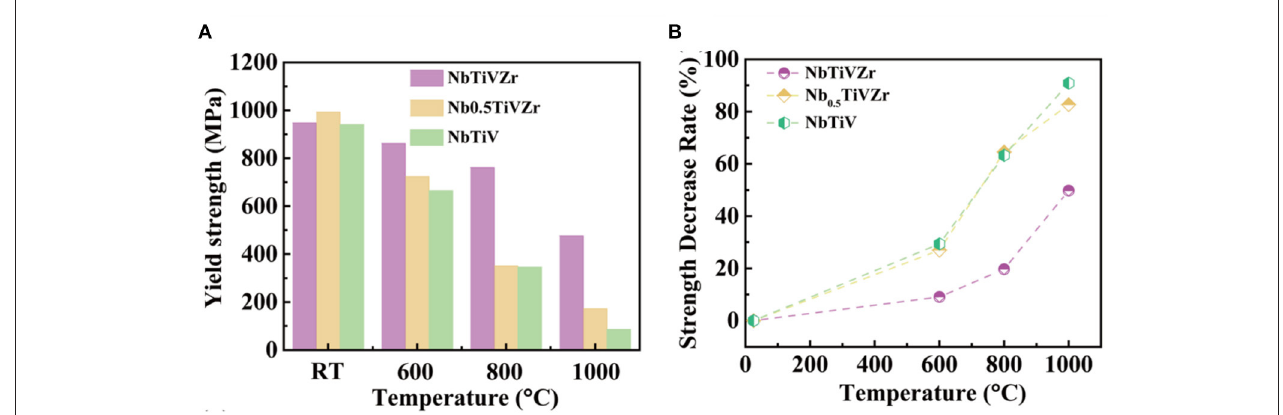
FIGURE 4 | Relationship between yield strength, strength change rate, and temperature for the NbTiVZr, Nb0.5TiVZr, and NbTiV alloys. (A) Yield strength vs. temperature and (B) strength change rate vs. temperature.